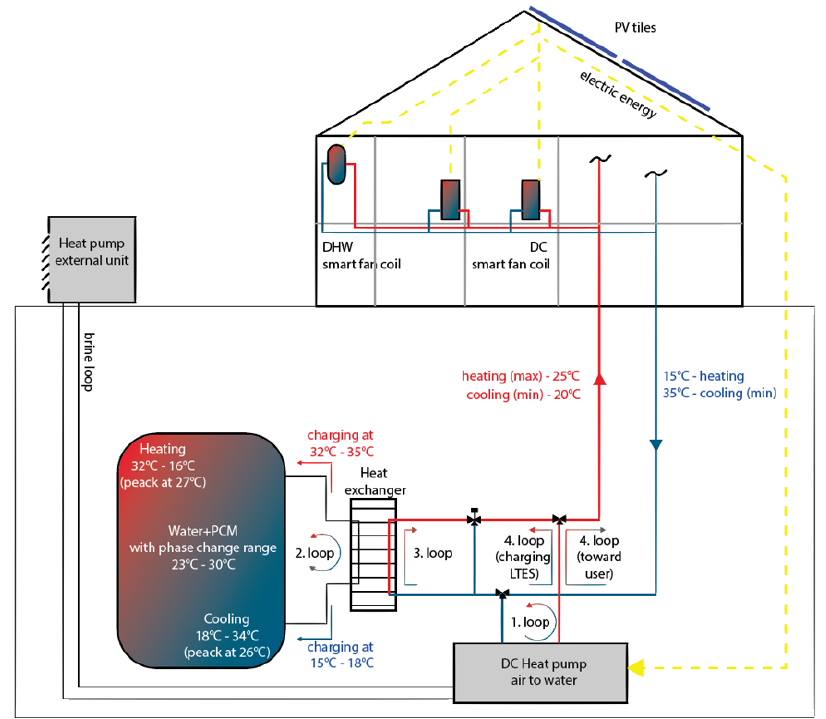
Figure 2. Scheme of the HEART system. 1. loop—charging of the latent thermal storage (LTS) unit with a heat pump (HP); 2. loop—circulation of water through the LTS unit during the charging or discharging process; 3. loop—discharging of heat/cold from the LTS unit into the heating/cooling system; 4. loop—the HP is simultaneously charging the LTS unit and the heating/cooling system.